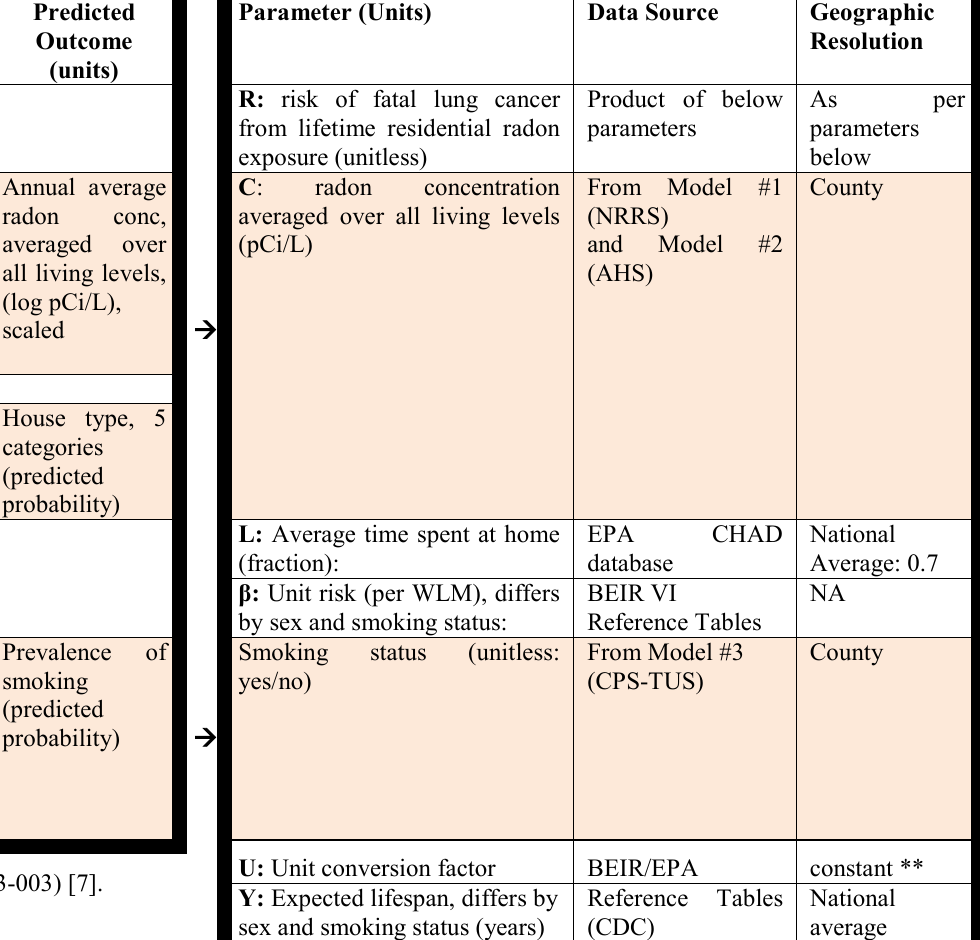
Regression models used to capture variability in exposure & risk